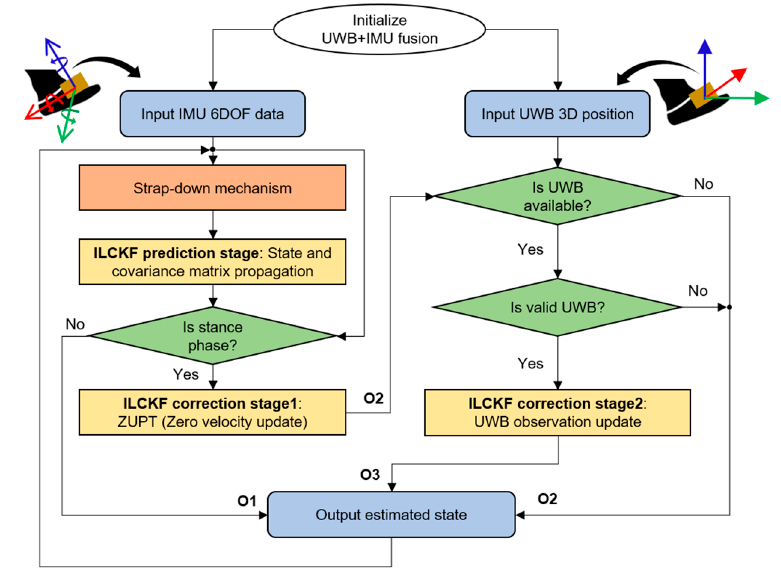
Figure 5. Structure of proposed UWB+IMU fusion.